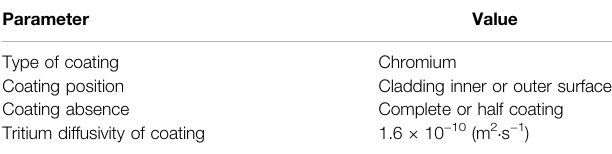
TABLE 4 | Parameters of coating with different coating positions and